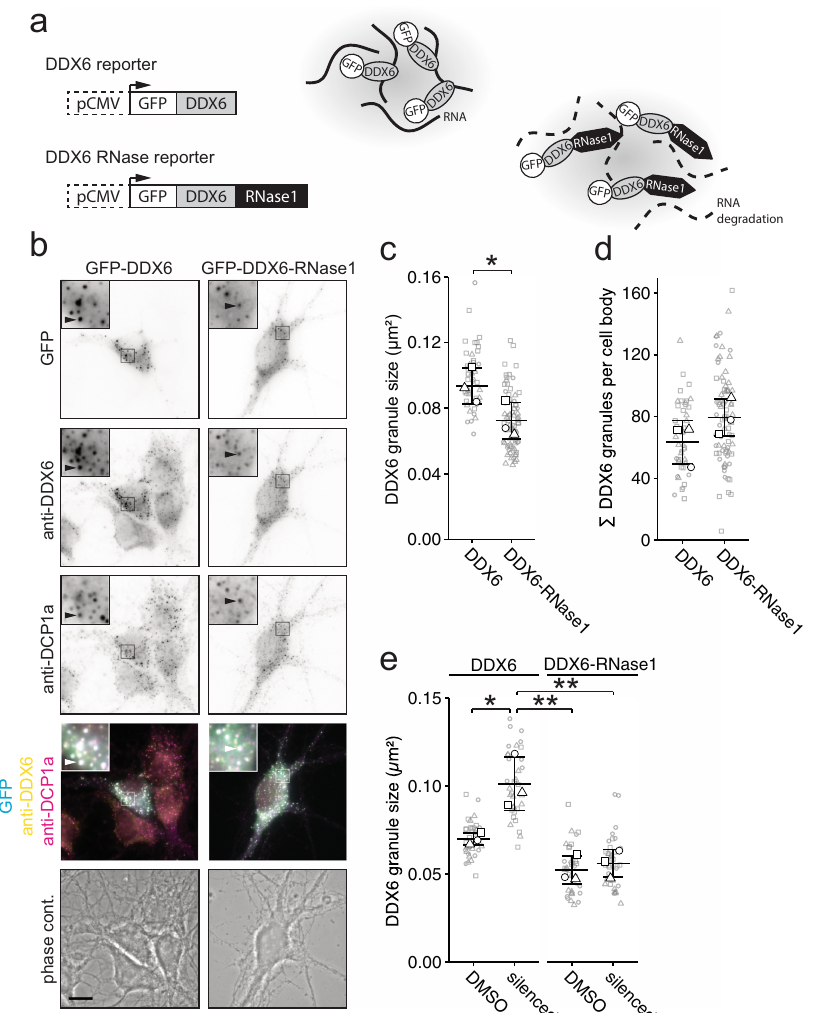
Fig. 5 RNA degradation in DDX6 granules results in disassembly. a Scheme of GFP-DDX6 and GFP-DDX6-RNase1 expression cassettes (right) and their use in an RNA-dependent assembly assay (left). b Representative examples of GFP fl uorescence, anti-DDX6 and anti-DCP1a immuno fl uorescence, merge, and phase contrast pictures of 14 DIV hippocampal neurons in culture, transfected with either GFP-DDX6 or GFP-DDX6-RNase1 reporters. Boxed regions in images are displayed as magni fi ed insets. Scale bars 10 µ m. Arrowheads indicate overlap. c , d , e Dot plots displaying average DDX6 granule size ( c , e ) or DDX6 granule number ( d ) of individual cell bodies as exempli fi ed in b , transfected with either GFP-DDX6 or GFP-DDX6-RNase1 reporters ( c , d ) and under vehicle treated or silenced conditions ( e ). Distinct dot symbols indicate biological replicates. Small gray symbols represent single cells while larger white symbols indicate the average of each replicate. Horizontal line and error bars represent mean of replicates and standard deviation ( n = 3 biologically independent experiments). Asterisks represent p -values obtained by two-sided Student ’ s t -test ( c , d ) or Tukey ’ s test post-hoc to one-way ANOVA analysis ( e ) (* p < 0.05, ** p < 0.01). p = 0.0306 ( c ), F 1,8 = 0.00045, GFP reporter; F 1,8 = 0.0128, neuronal inhibition ( e